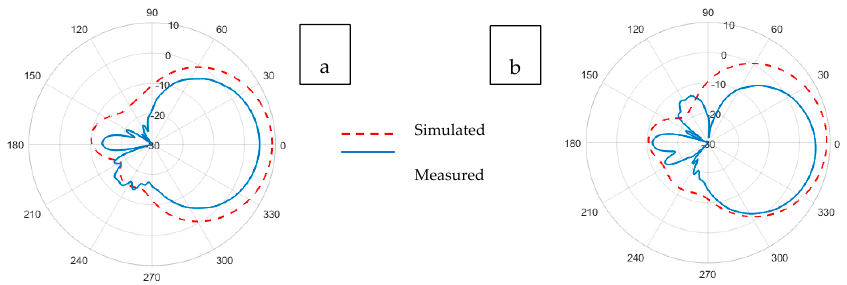
Figure 15. Simulated and experimental ( a ) E-plane and ( b ) H-plane radiation patterns of Koln-based non-perforated RRMPA at 2.45 GHz.